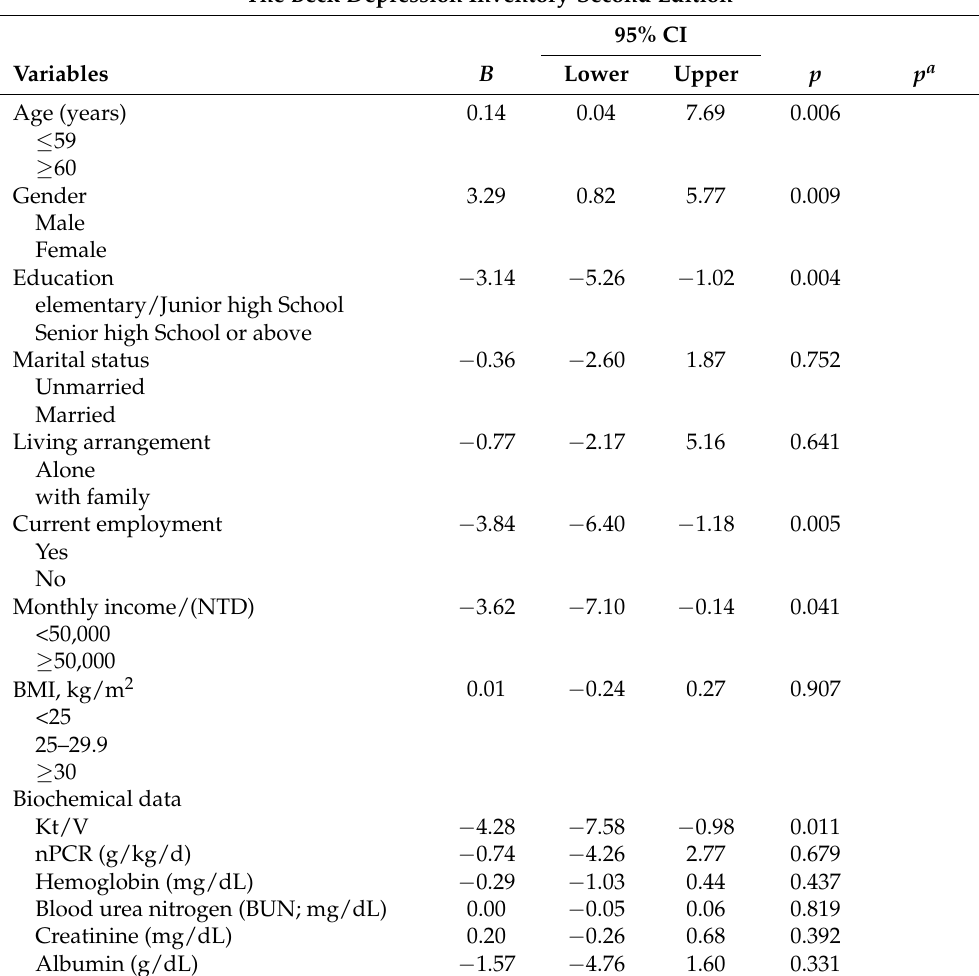
Table 2. Analysis of factors associated with Beck Depression Inventory-Second Edition score and sociodemographic characteristics ( n = 120). The Beck Depression Inventory-Second